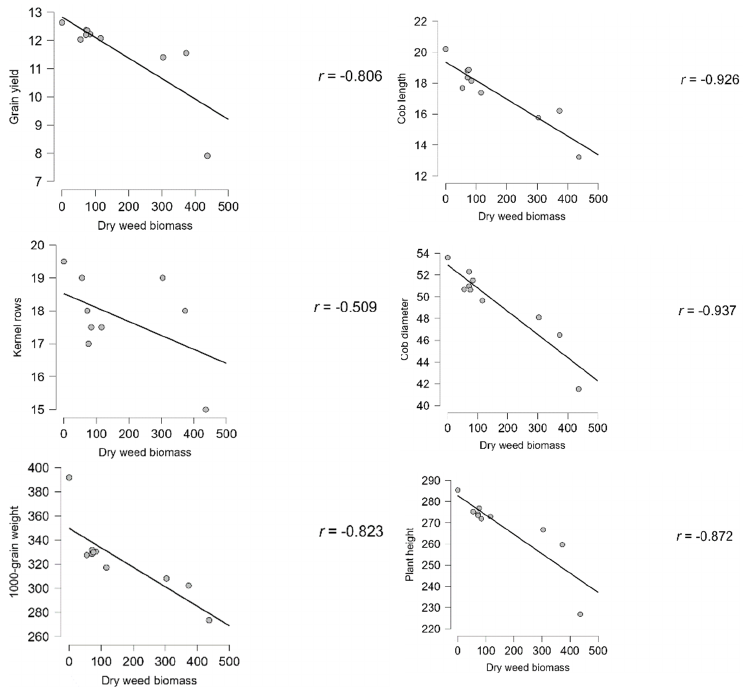
Figure 7. Dry weight and other parameter correlations.